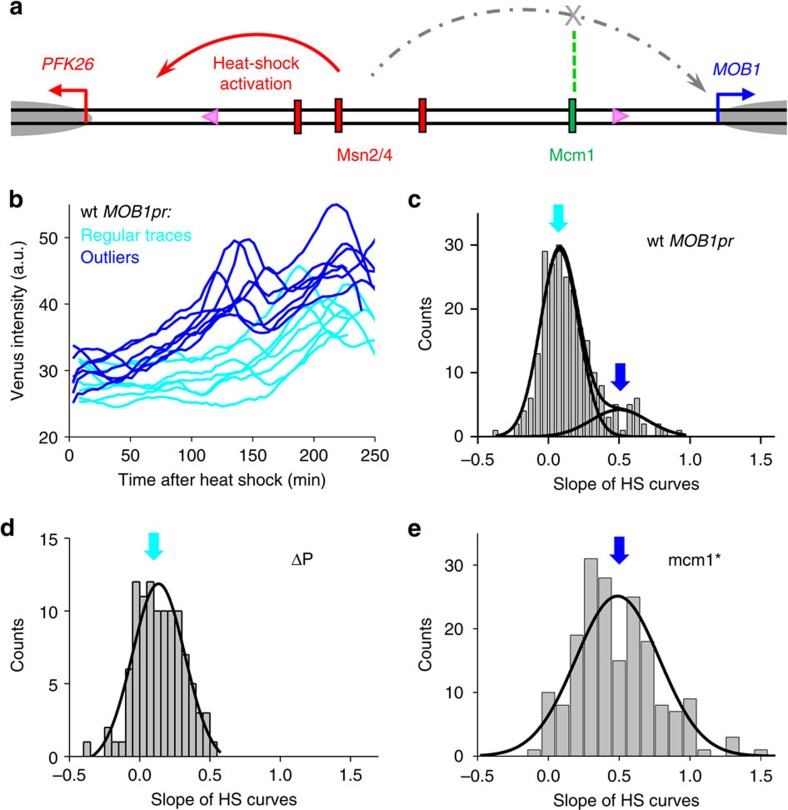
Stochastic MOB1 heat-shock activation from the PFK26UAS.(a) Genomic structure of PFK26–MOB1 divergent promoter. Red rectangles, putative Msn2/4 binding sites; green rectangle, Mcm1 binding site; pink triangles, two non-consensus TATA elements; red and blue arrows, TSSs and grey ovals, nucleosomes. (b) Representative heat-shock (HS) traces of Venus driven by PFK26–MOB1 promoter from the MOB1 side in single yeast cells. In most cells, MOB1pr-Venus showed no activation during the heat-shock phase (first 2 h), but started to oscillate when cells adapted and resumed growth (cyan traces). However, MOB1pr showed significant heat-shock response in a small fraction of cells (blue traces). (c-e) Histograms of heat-shock intensity driven by WT MOB1 promoter (c) and its variants (d,e) among individual cells. This intensity was quantified by the slopes of the fluorescent traces during heat shock. ΔP, deletion of the PFK26 side of the promoter including all the Msn2/4 binding sites; mcm1*, mutation of the Mcm1 binding site that leads to Mcm1 depletion from the promoter34. The WT MOB1 promoter showed bimodal heat-shock response (c); in contrast, the two mutant promoters showed unimodal response corresponding to the lower (d) and higher peaks (e) respectively. Number of traces: WT, 236; ΔP, 105; mcm1*, 185.